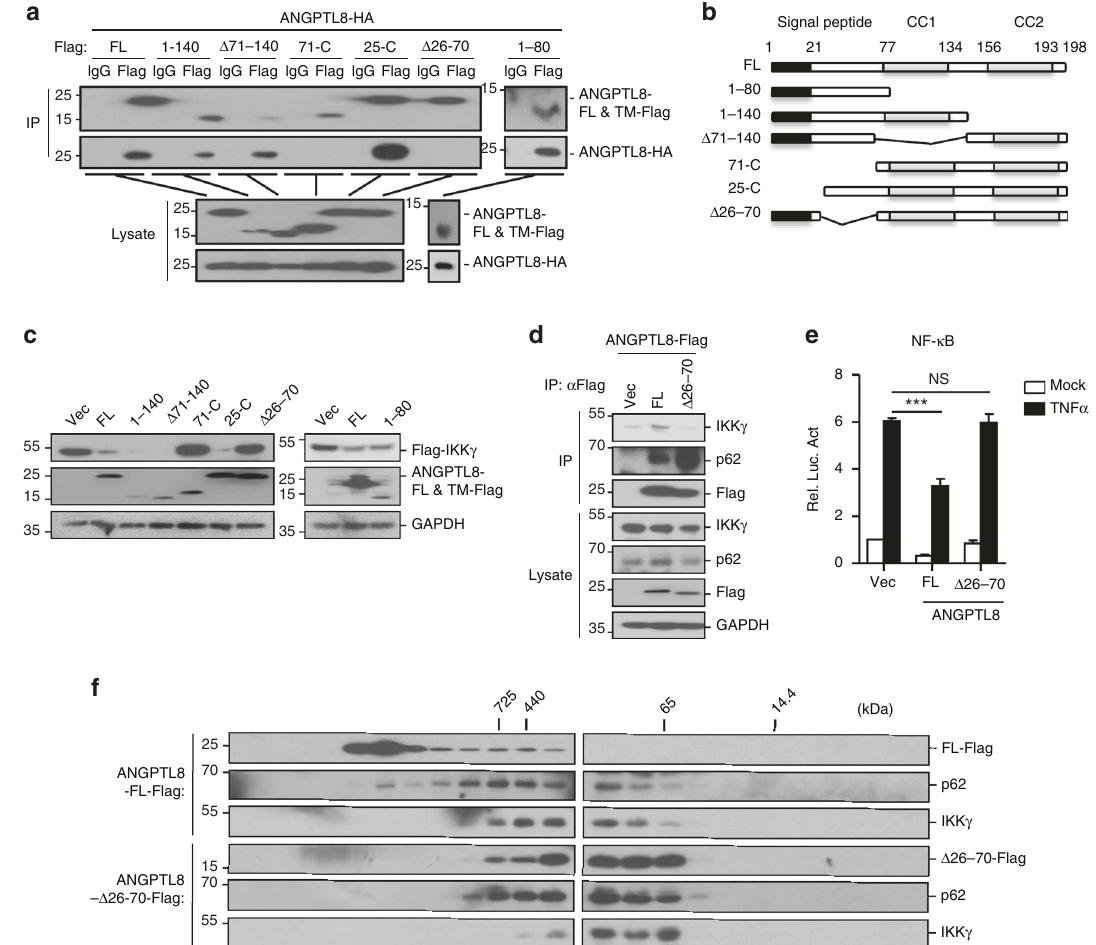
Fig. 9 ANGPTL8 self-aggregation is essential for the degradation of IKK γ . a Domain mapping of the ANGPTL8 self-aggregation in HEK293T cells. b A schematic presentation of human ANGPTL8 and its truncation mutants. c The effects of ANGPTL8 and its truncation mutants on the degradation of IKK γ in HEK293T cells. d The ANGPTL8- Δ 26 – 70 shows a diminished interaction with IKK γ . Three dishes of HEK293T cells (2 × 10 6 cells per dish) were transfected with indicated plasmids, 24 h later, cells were lysed and subjected to co-IP and followed immunoblots by indicated antibodies. e The effects of the full-length or − Δ 26 − 70 truncation mutant of ANGPTL8 on the TNF α -induced NF- κ B activation ( n = 3). f Analysis of protein complex containing ANGPTL8, p62 and IKK γ by size-exclusion chromatography. HEK293T cells (2 × 10 6 ) were transfected with indicated plasmids for 24 h later before cells were lysed and subjected to size-exclusion chromatography. Data are shown as the mean ± SEM in e , unpaired two-tailed Student ’ s test was used for statistics ( e ). *** p < 0.0001, NS > 0.05. Data are representative of three independent experiments. FL full length, TM truncation experiments with ANGPTL8/Angptl8 were done by mouse anti-ANGPTL8 poly- clonal antibody which was raised against recombinant human full-length ANGPTL8 with standard protocols. A list of commercial reagents, and other antibodies and dilutions used in the present study was provided in Supplementary Table 2. HepG2 (CL-0103000), HEK293T (CL-0005), and A549 (CL-0016) cells, which were analyzed with authenticated STR locus and tested for mycoplasma contamination, were purchased from Procell Biotech. (Wuhan, China).